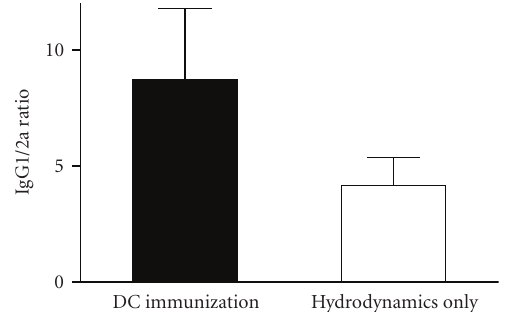
Figure 4: The ratio of anti-HA specific IgG1/2a in DC immuniza- tion. The BM-DCs expressing HA were injected into mice ( n = 5) . For control, hydrodynamic injection of pCAGGS-HA was carried out ( n = 4) . After booster immunization, the ratio of anti-HA specific IgG1/2a was determined using flow cytomery analysis. Data represent means ± SE of each